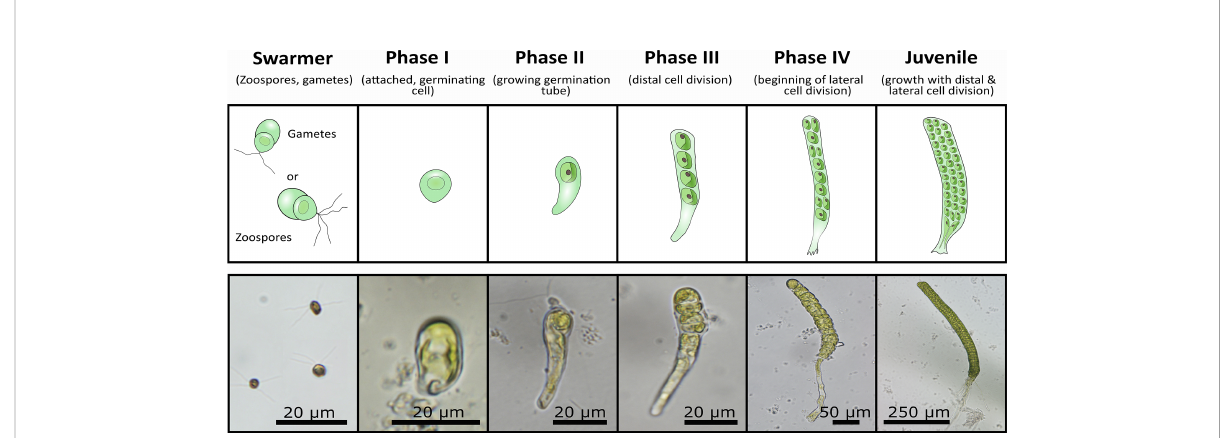
FIGURE 1 Overview about the four different early ontogenetic development phases from swarmer until juvenile stage in Ulva fenestrata . A schematic overview (upper row) is connected to original microscopic images (lower row), which show the single ontogenetic developmental stages that are similar in clonal (originating form gametophytes) and recombinant gametophytes (originating from sporophytes). This universal system for ontogenetic development of all juvenile life-history-phases in U. fenestrata was used to determine the development rate and success of the single gametophytic